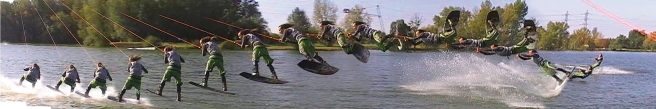
Multiple-exposure stroboscopic photograph.This illustrates (inasmuch as possible with a static image) the perception
experienced during trailing.